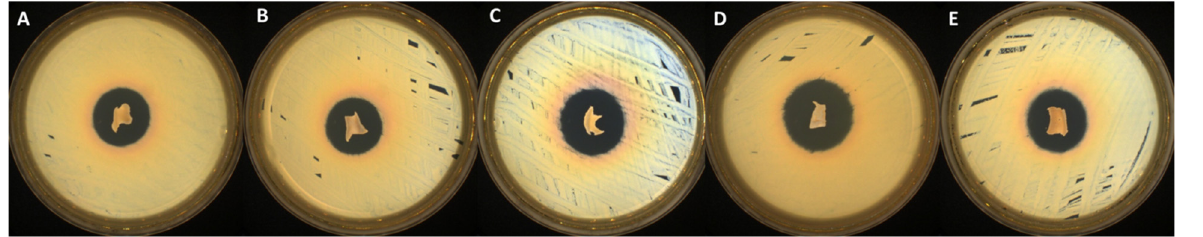
Figure 6. Antifungal activity of the tested samples: ( A ) PVA_PEBSA 25/75 _Thy_ α -Tcp, ( B ) PVA_PEBSA 50/50 _Thy_ α -Tcp, ( C ) PVA_PEBSA 75/25 _Thy_ α -Tcp, ( D ) PVA_PEBSA 50/50 _2xThy_ α -Tcp, and ( E ) PVA_PEBSA 50/50 _Thy_2x α -Tcp against C. albicans . The samples proved to be very effective especially against fungal strain represented by C. albicans (up to 38 mm of inhibition zone). Moreover, no significant differences were noticed in terms of antimicrobial activity among systems with different ratios between EB/SA comonomers. A smaller zone of inhibition was noticed in case of PVA_PEBSA 50/50 _Thy_2x α -Tcp